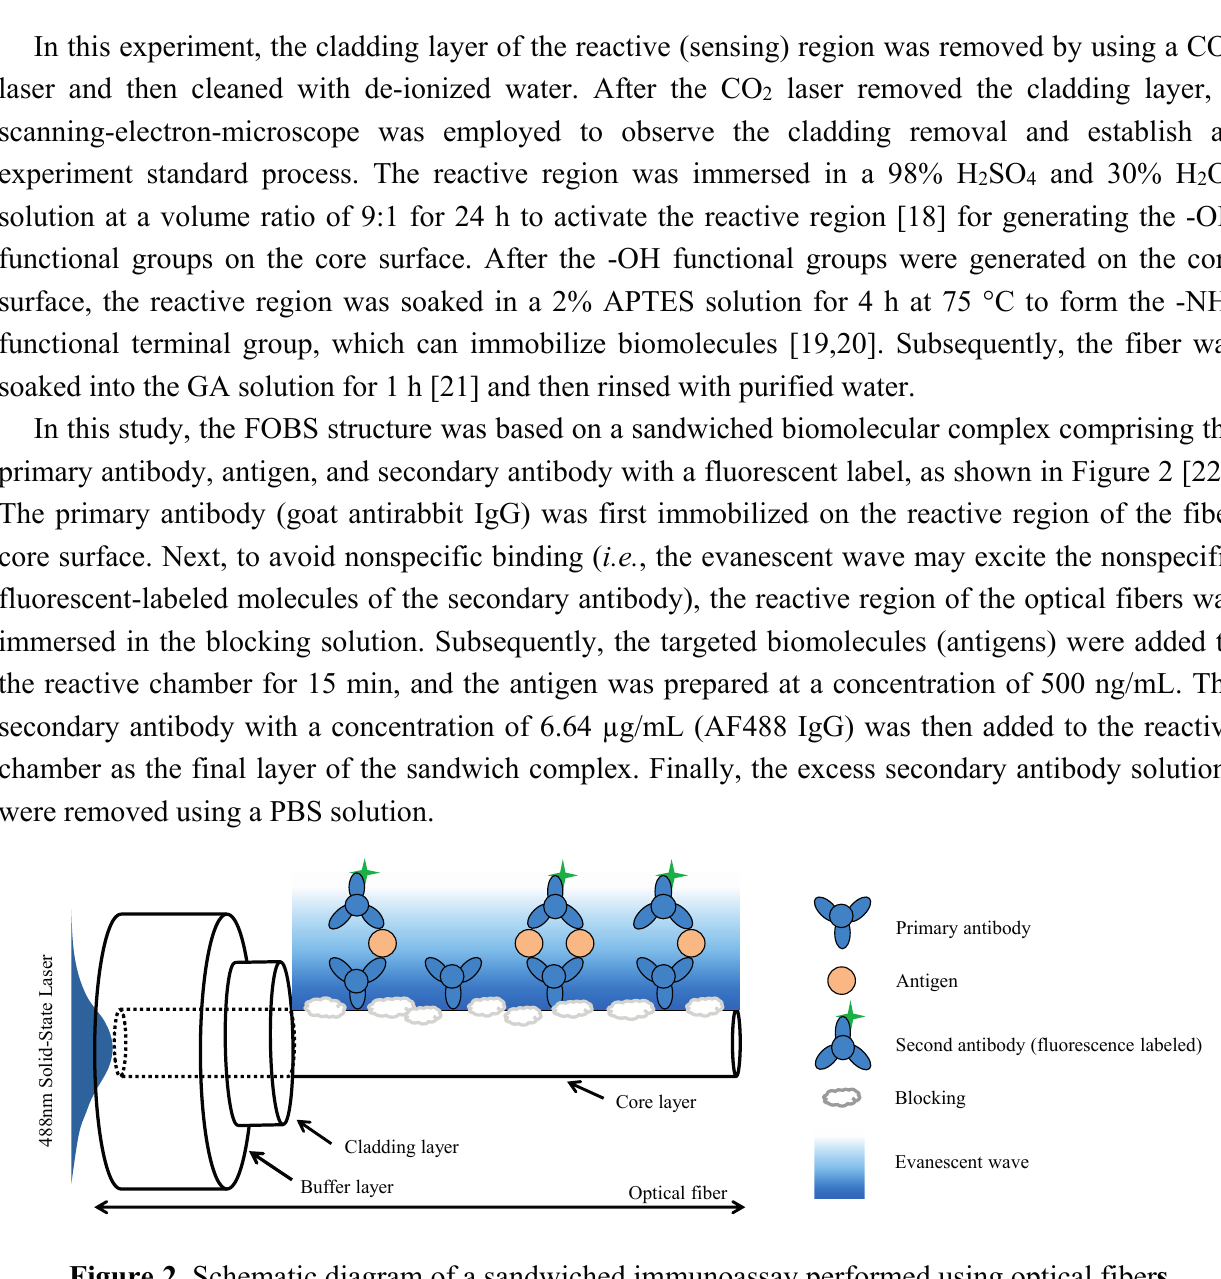
Figure 2. Schematic diagram of a sandwiched immunoassay performed using optical fiber s under evanescent wave